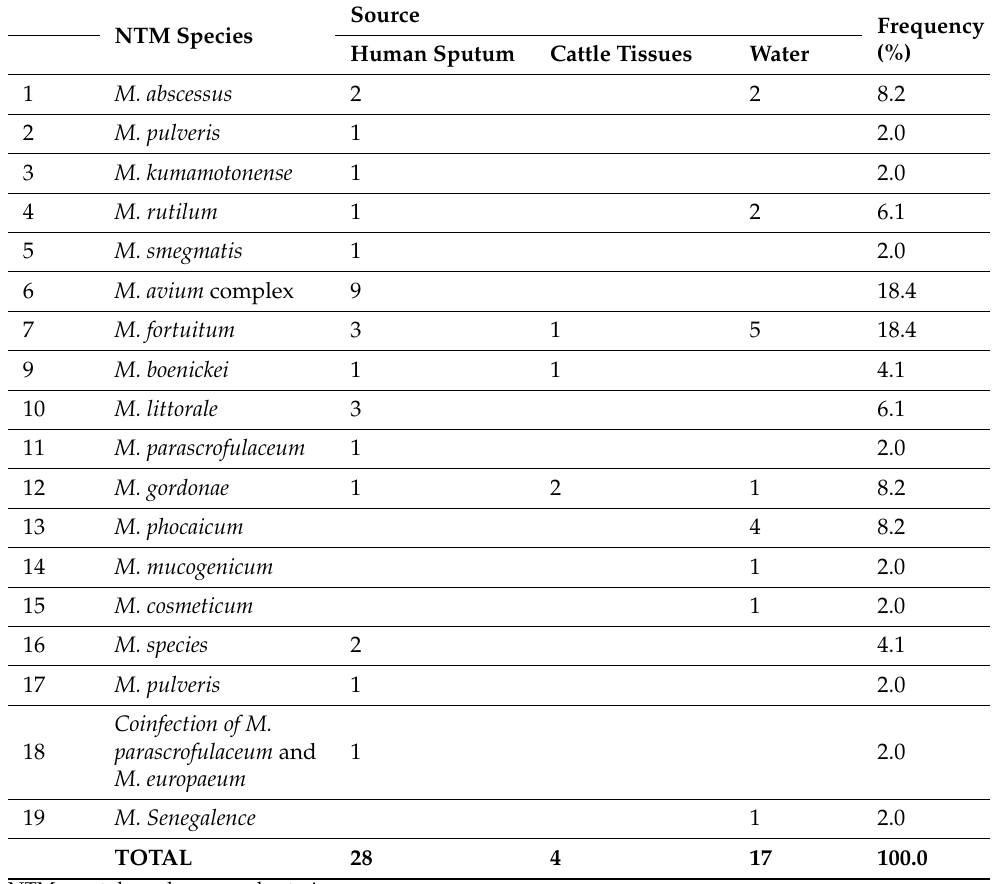
Table 5. NTM species distribution at the human–livestock–environment